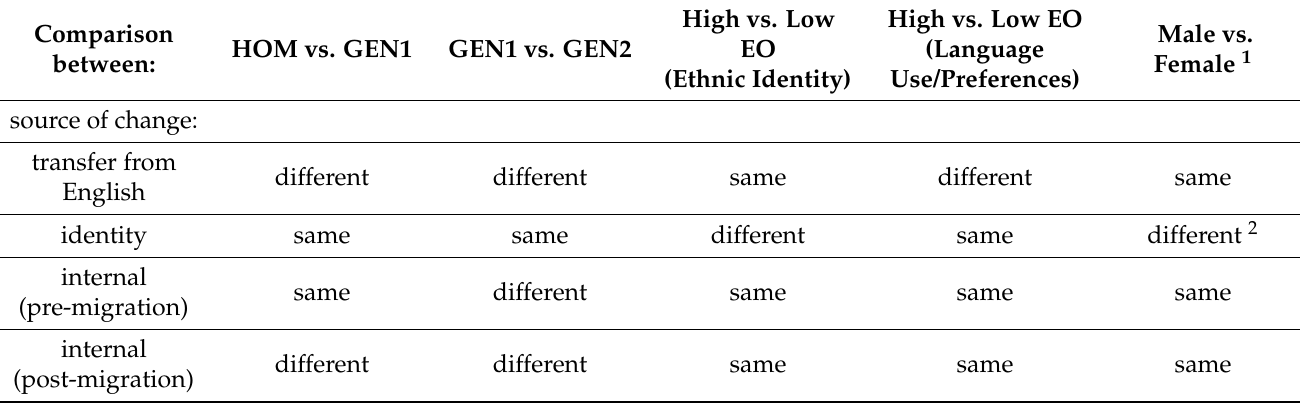
Table 1. Profiles of each source of variation and change according to rate and constraint-hierarchy patterns of inter- group